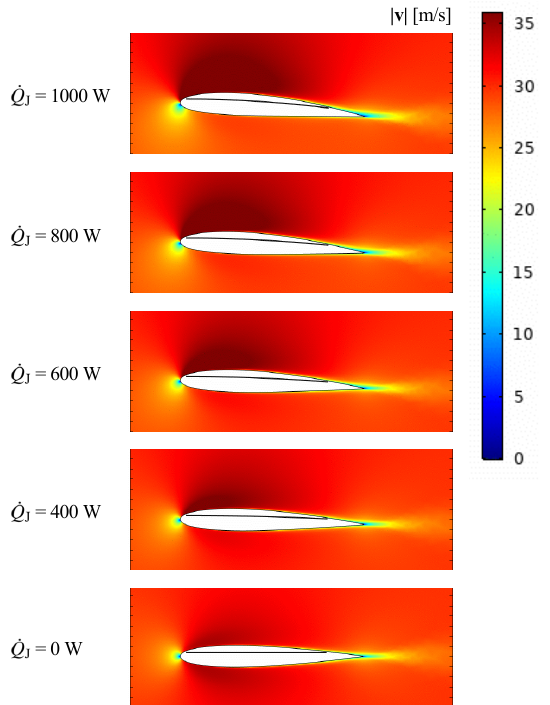
Figure 6. Qualitative maps of air velocity magnitude | v | at a free-stream air velocity v 0 = 30 m/s for cases of power feed ˙ Q J from 0 to 1000